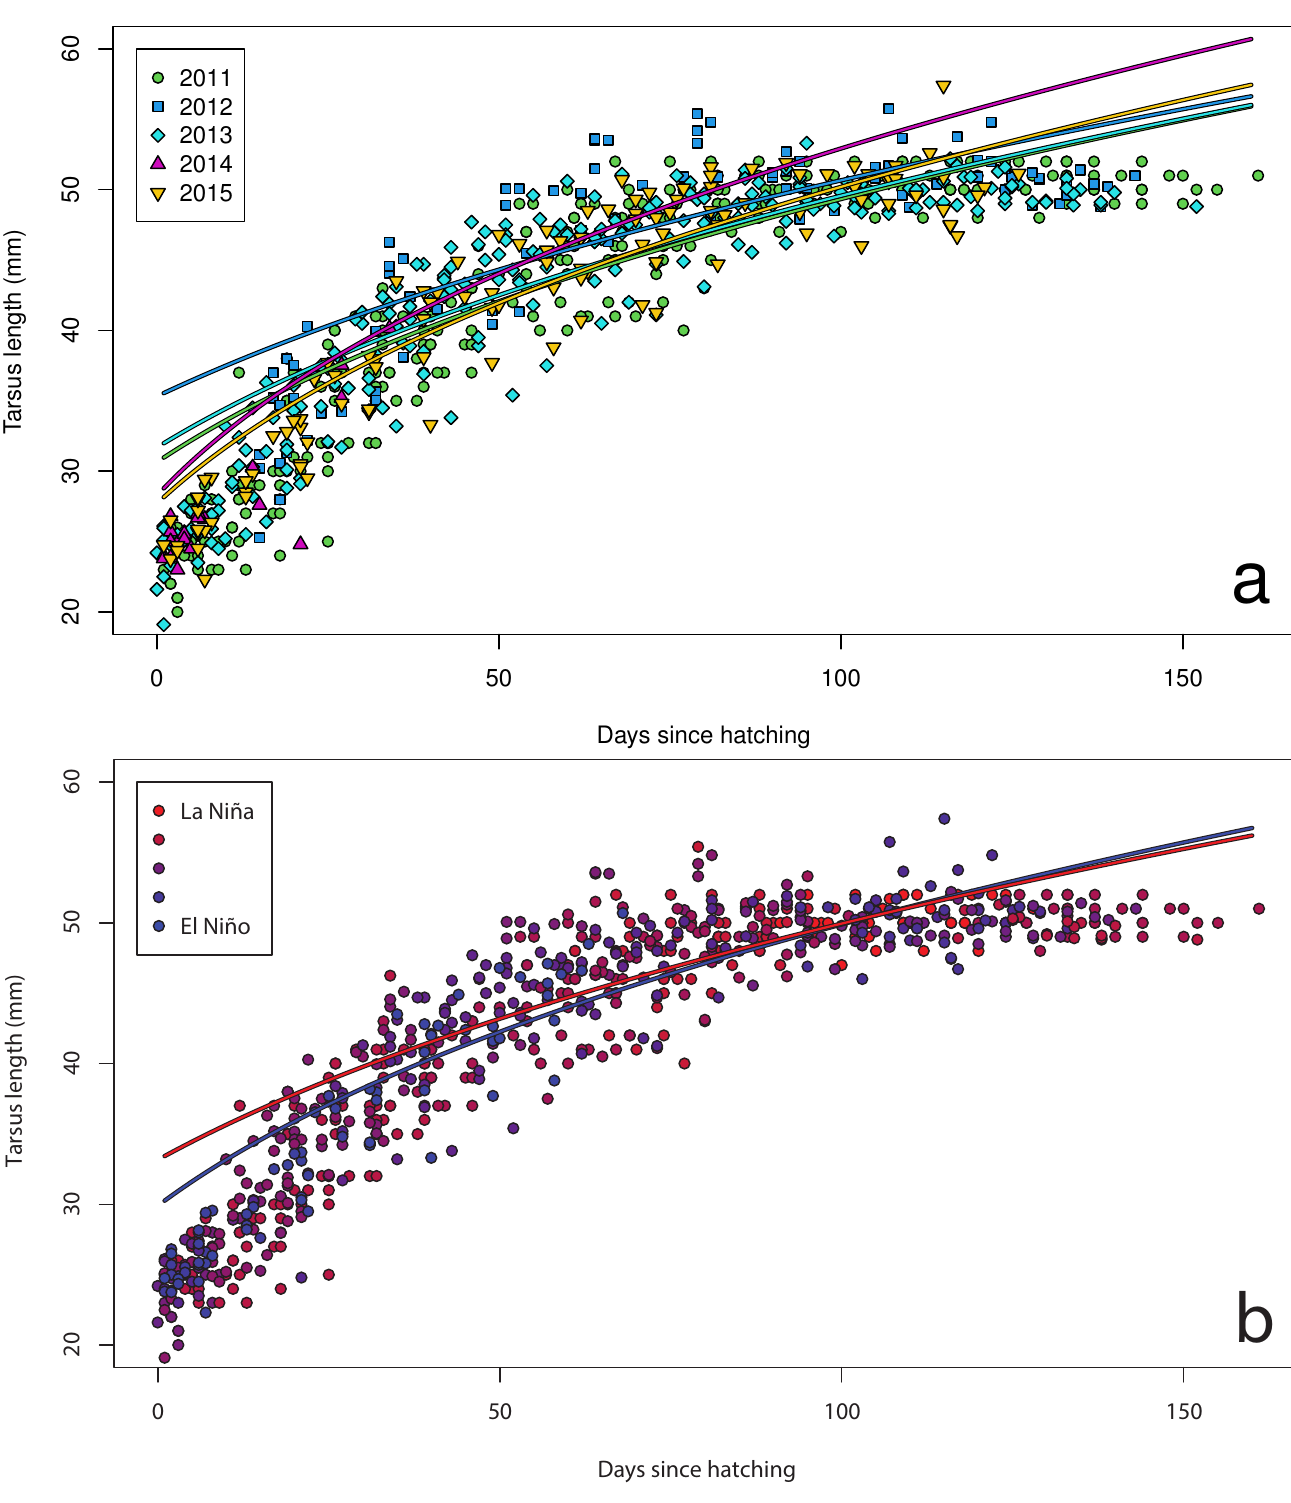
Figure 5. Tarsus length growth curves for chicks ( n = 72) on Te H¯awere-a-Maki from 2011 to 2015: ( a ) annually; ( b ) monthly Southern Oscillation Index. Lines of best fit indicate years and SOI = –1 or